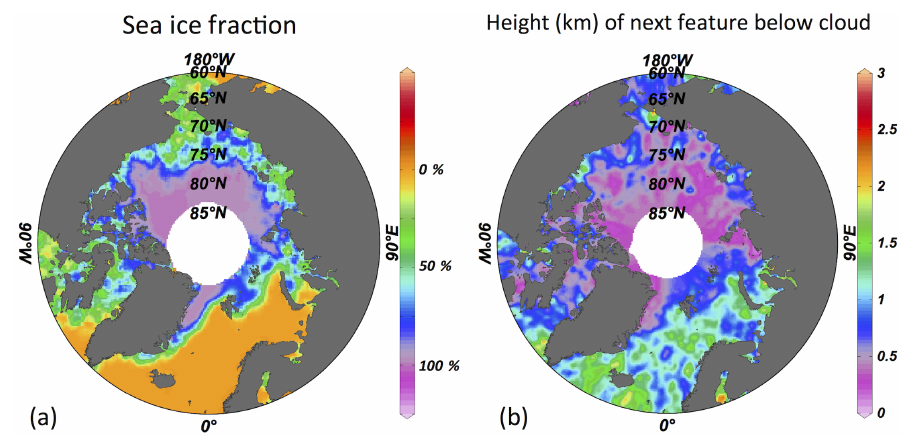
Figure 3. The weighted-average gridded maps of features below individual cloud points from Fig. 1b for (a) sea ice fraction, and (b) height of the next-lowest feature associated with individual cloud profiles, where a value of 0 indicates that the ocean surface or sea ice was the next-lowest feature. Over open ocean, ONLi clouds were much more likely to overlay another cloud than over sea ice.